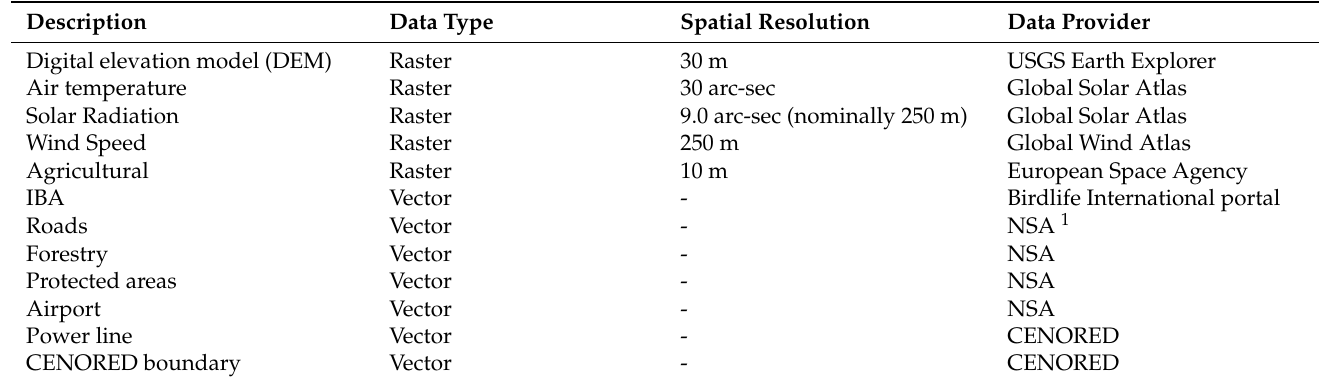
Table 1. Data used in this